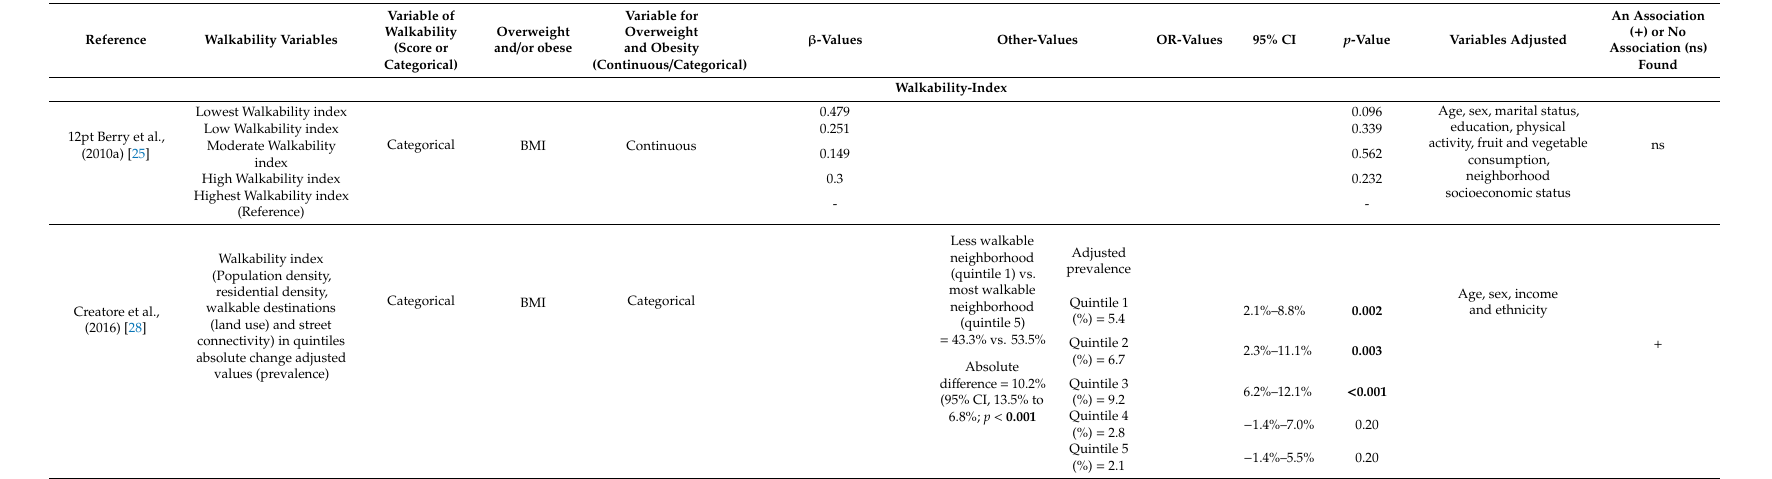
Table 3. Synthesis of